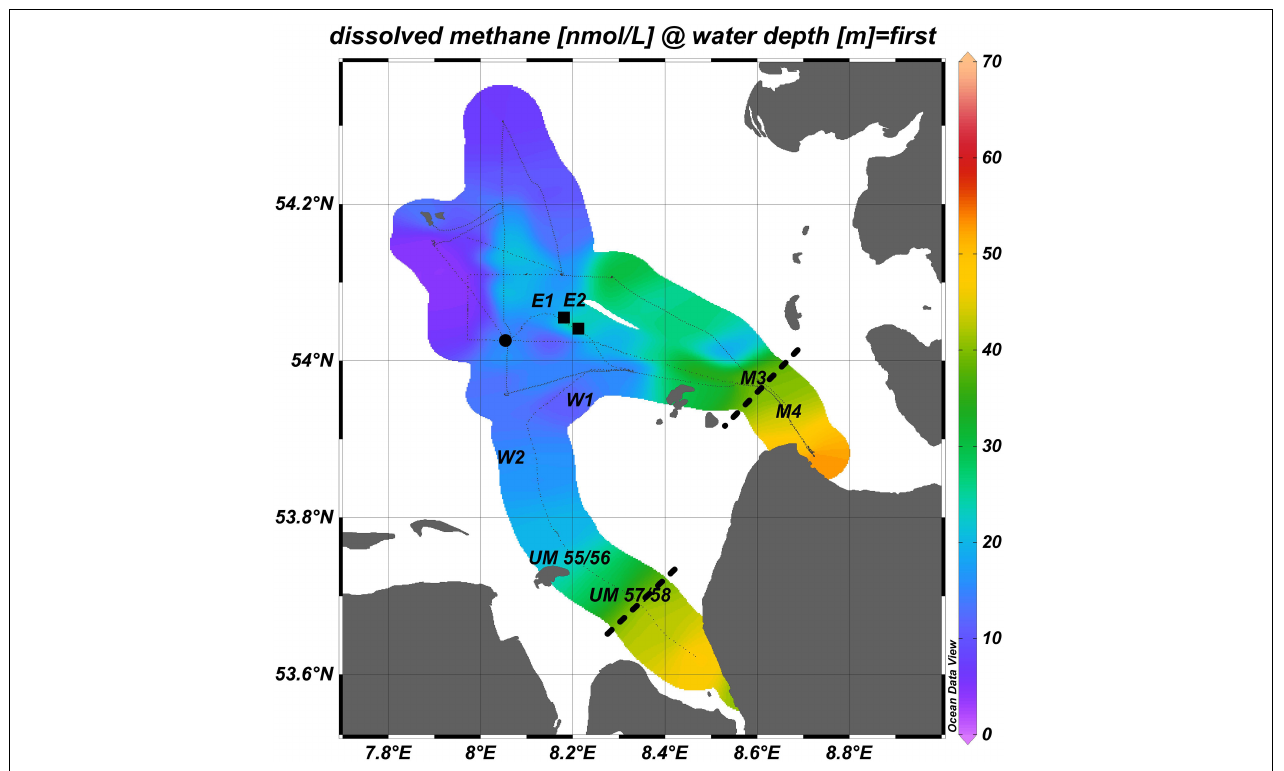
FIGURE 2 | Methane concentrations in surface waters (all data, both days, both ships). The dotted lines indicate the 25-salinity limit. Shown are also the stations where samples for isotopic analyses had been taken (M3, M4, UM55/56, UM57/58). The symbols depict the area of local methane increases, due to increase of oxygen decrease (dot) and turbidity (squares). Indicated are also the stations E1, E2 and W1, W2.